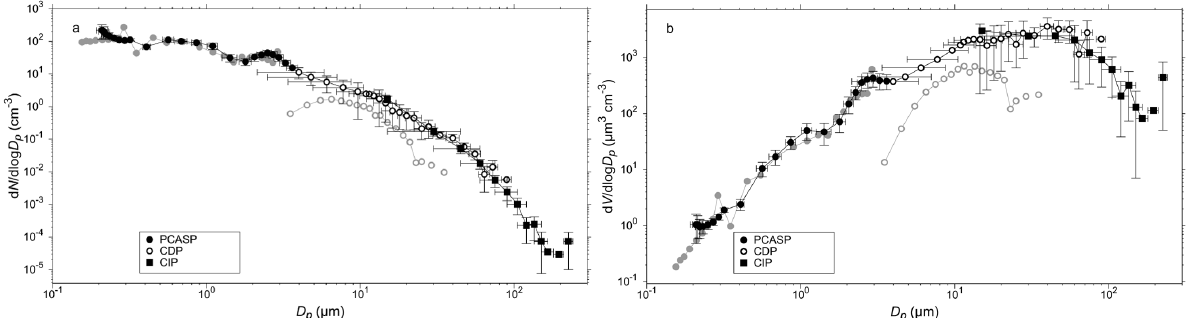
Fig. 10. Size distribution of desert dust aerosol measured by the PCASP, CDP and CIP during a run at 800m above the desert surface. For the PCASP and CDP, the distributions derived using the manufacturer’s specification are in grey and the calibrated and refractive index corrected data are in black. The number, N , and volume V , are shown as a function of particle diameter D p . Error bars which extend to negative numbers on the log scale have been omitted for